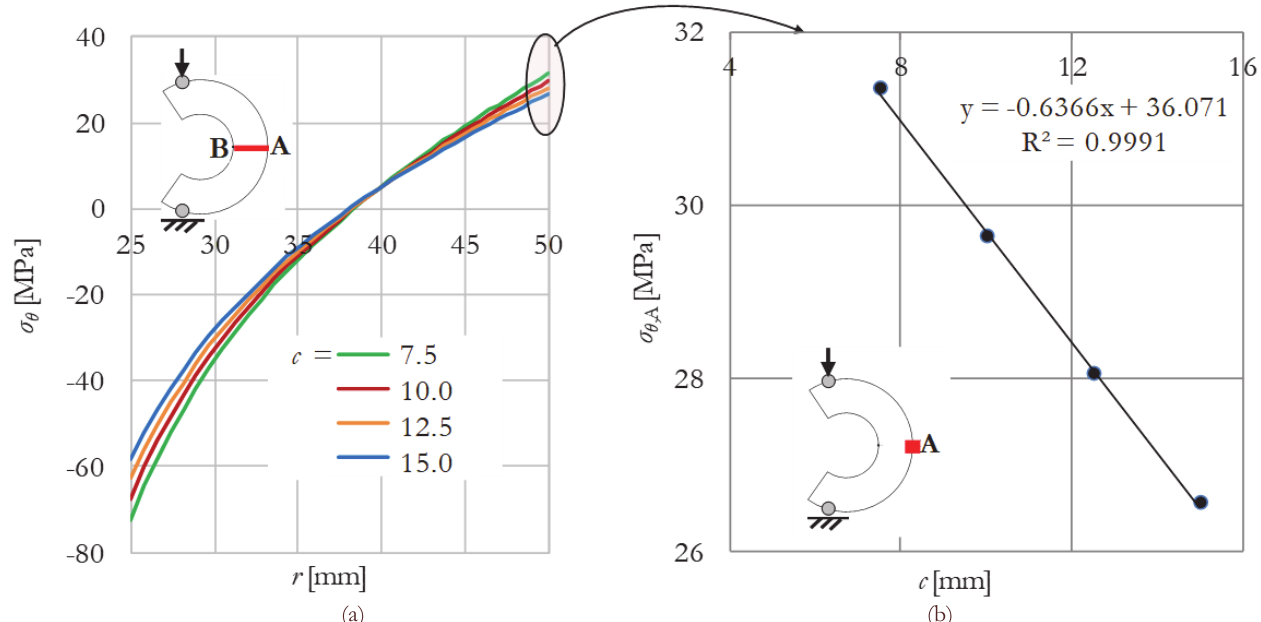
Figure 14: (a) The variation of the transverse stress along locus AB for four different values of the eccentricity c (in mm); (b) The dependence of the maximum tensile stress (i.e., the stress developed at point A) on eccentricity c